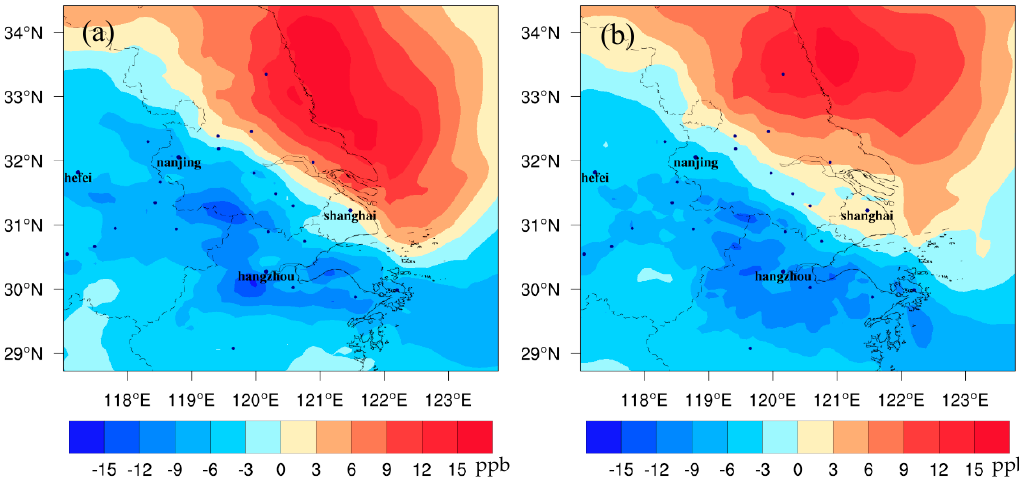
Figure 6. The spatial distribution of the monthly averaged di ff erences of O 3 between FUTMET and PREMET ( a ) during the daytime (from 7:00 to 18:00 LST) and ( b ) at night (from 19:00 to 6:00 LST).